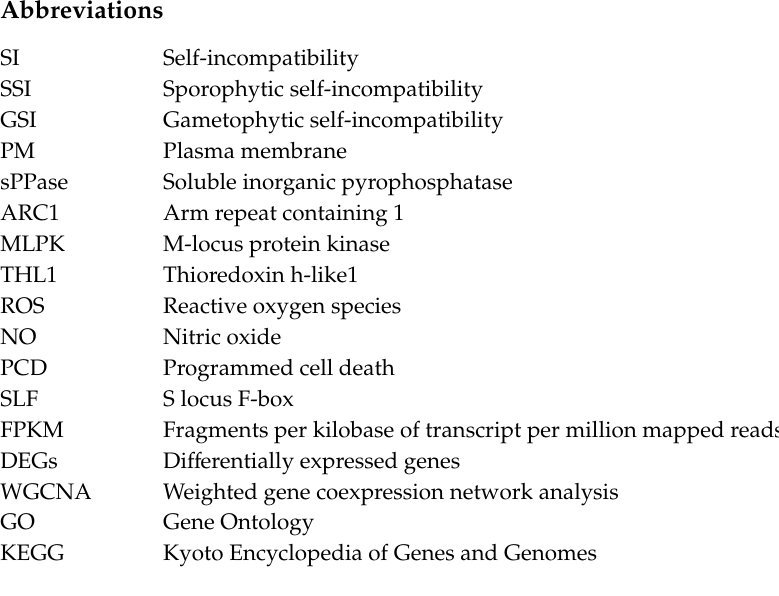
Table S1. Transcriptome sequencing output statistics. Table S2. All gene expression levels. Table S3. List of di ff erentially expressed genes (DEGs). Table S4. Gene list of 18 modules in self- and cross-pollinated pistils. Table S5. Enriched GO categories of the DEGs. Table S6. KEGG enrichment results of the DEGs. Table S7. DEGs involved in protein phosphorylation triggered by SI. Table S8. DEGs involved in calcium, ROS, and NO signaling triggered by SI. Table S9. DEGs involved in plant hormone signaling triggered by SI. Table S10. DEGs involved in cytoskeleton triggered by SI. Table S11. Primers used in qRT-PCR analysis. Figure S1. The number and length distribution of assembled unigenes. Figure S2. Unigene annotation using seven databases. Figure S3. qRT-PCR validation of expression profiles of DEGs. Figure S4. Hierarchical cluster heatmap comparison of the di ff erentially expressed genes. Distinct expression patterns were revealed for non-, self-, and cross-pollination at 5 min, 10 min, and 30 min, respectively. NP, nonpollination; SP, self-pollination; and CP, cross-pollination. Author Contributions: G.L. and S.C. planned and designed the research. D.Q., H.L., and X.D. contributed